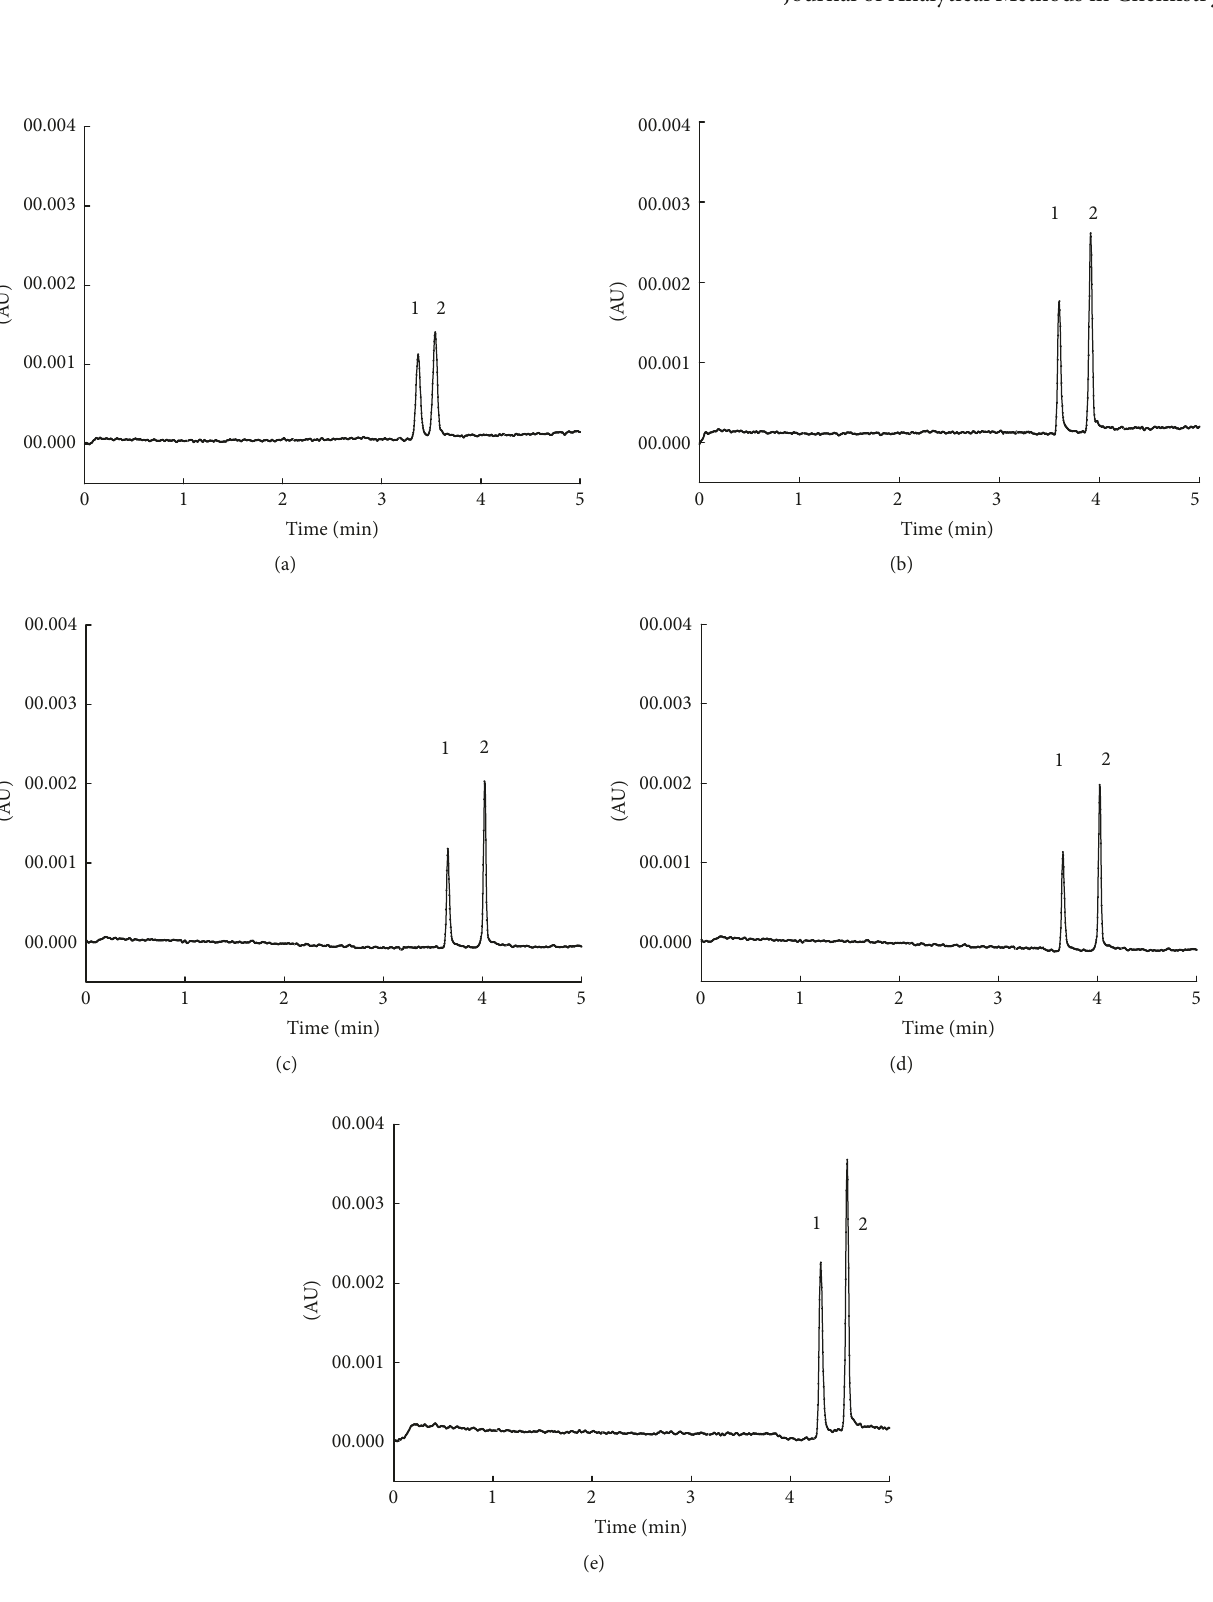
Figure 3: Effect of different buffer concentration on the separation. Chromatogram identification: (a) 10mmol/L; (b) 20 mmol/L; (c) 30 mmol/L; (d) 35 mmol/L; (e) 40mmol/L. Separation conditions and peak identification were as in Figure